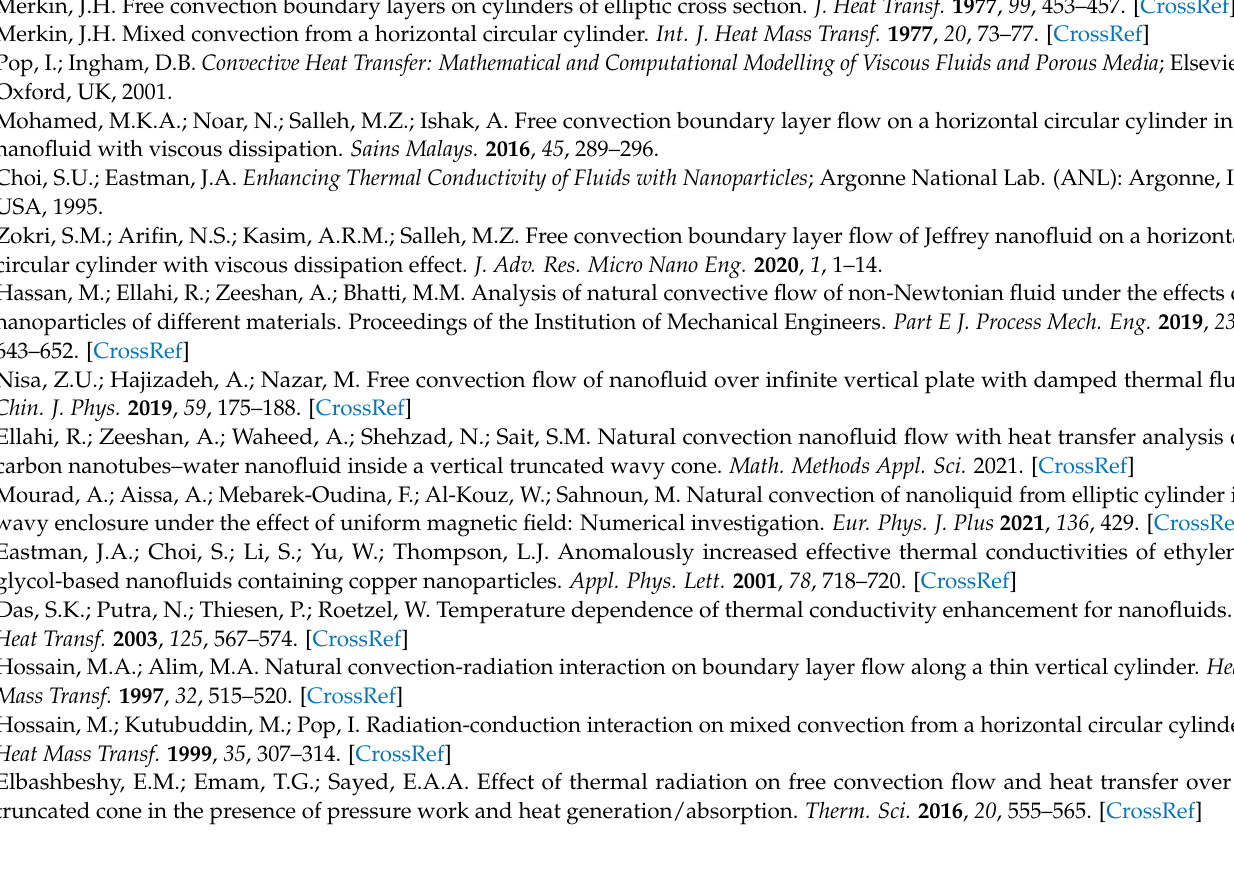
plot (eta,s(:,kmax(1))) xlabel(‘ \ eta’) ylabel(‘ \ theta( \ eta)’) hold on figure (3) plot (eta,u(:,kmax(1))) xlabel(‘ \ eta’) ylabel(‘u( \ eta)’) hold on figure (4) plot (x,cf) xlabel(‘x’) ylabel(‘Skin friction’) hold on figure (5) plot (x,q) xlabel(‘x’) ylabel(‘Sherwood number’) hold on figure (6) plot (x,h) xlabel(‘x’) ylabel(‘Nusselt number’) hold